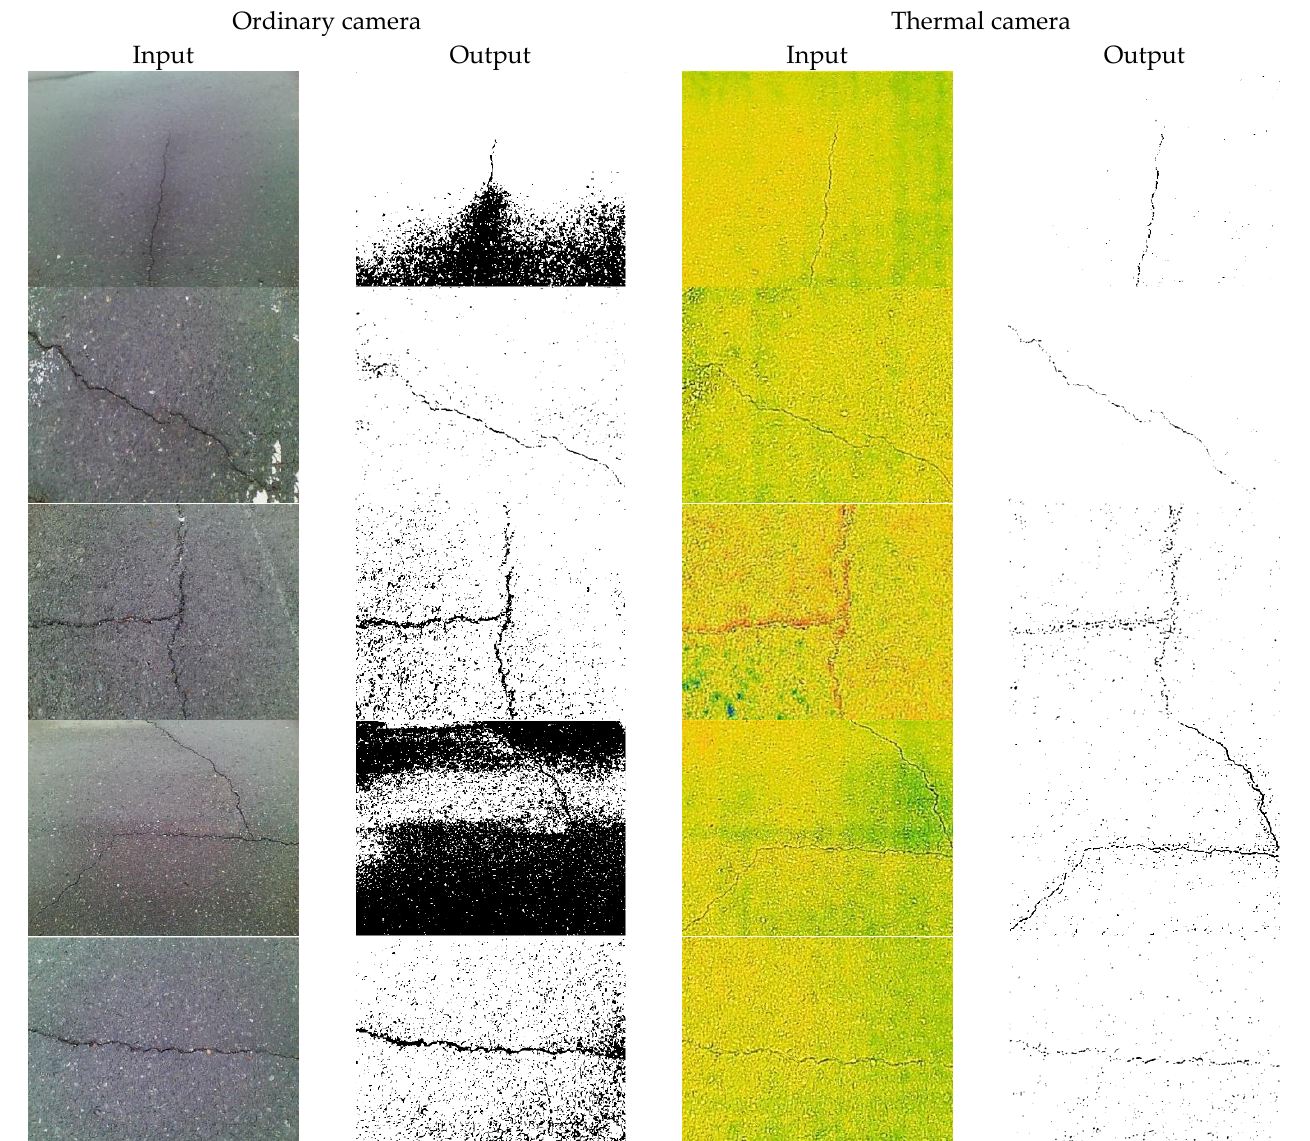
Figure 13. Sample outputs of corresponding inputs from ordinary and thermal cameras.